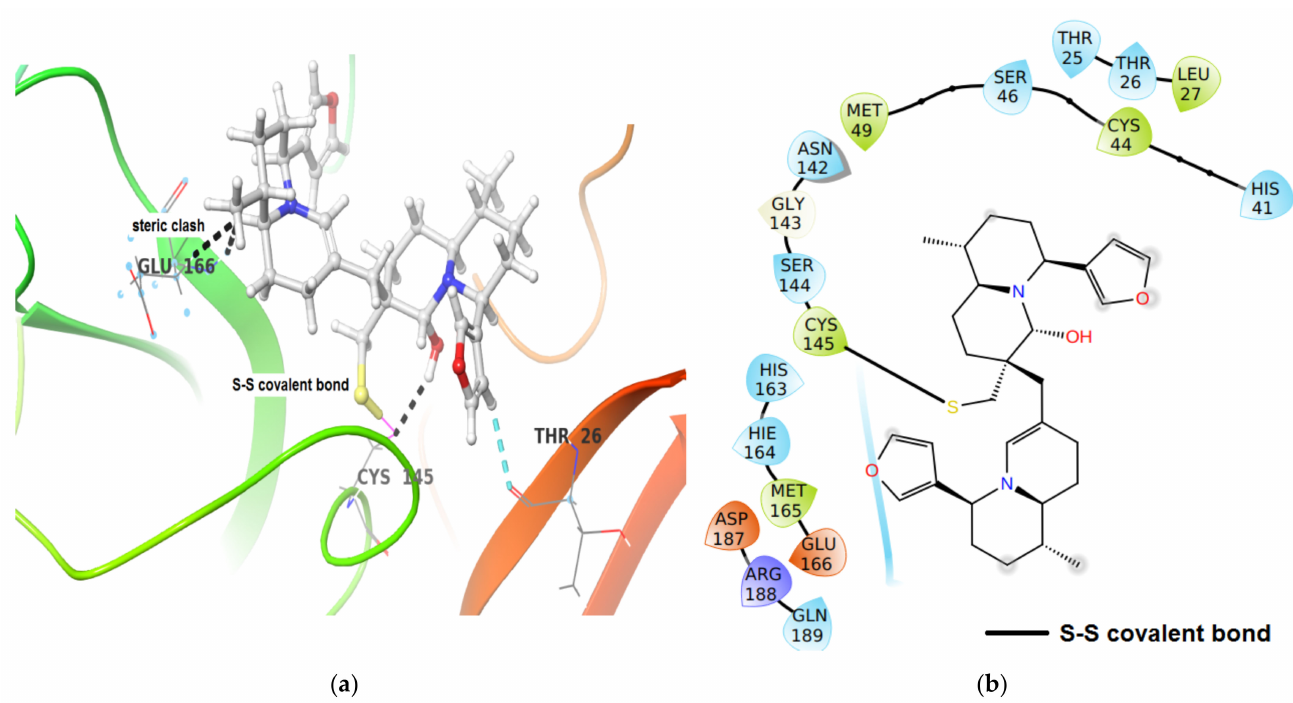
Figure 10. ( a ) 3-D representation of intermediate DTBN (iDTBN) docked to M pro . C-H ... O hydrogen bonds are displayed in cyan blue dotted lines and steric clashes were displayed in black dotted lines, ( b ) 2-D Ligand interaction diagram of iDTBN docked to M pro